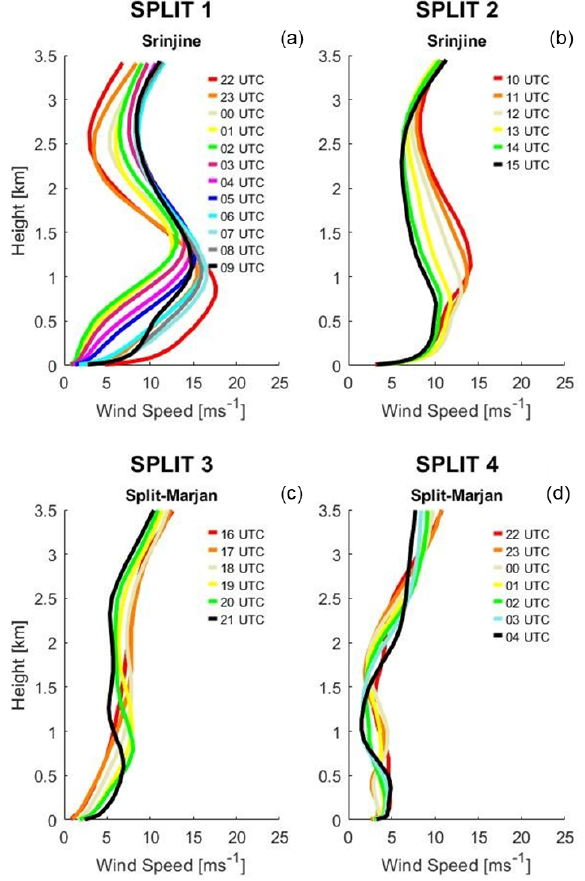
Figure 13. Vertical profiles of wind speed (ms − 1 ) at Srinjine and Split-Marjan locations for the periods (a) SPLIT 1 (from 22:00UTC on 16 July 2017 to 09:00UTC on 17 July 2017), (b) SPLIT 2 (from 10:00 to 14:00UTC on 17 July 2017), (c) SPLIT 3 (from 15:00 to 21:00UTC on 17 July 2017), and (d) SPLIT 4 (from 22:00UTC on 17 July 2017 to 04:00UTC on 18 July 2017) from the ALADIN model. See Fig. 2 for location of Split-Marjan and Srinjine (noted as